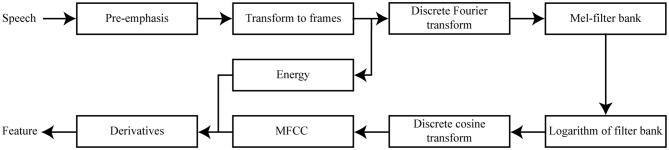
Diagram visualizing the features used in our acoustic distance algorithm.